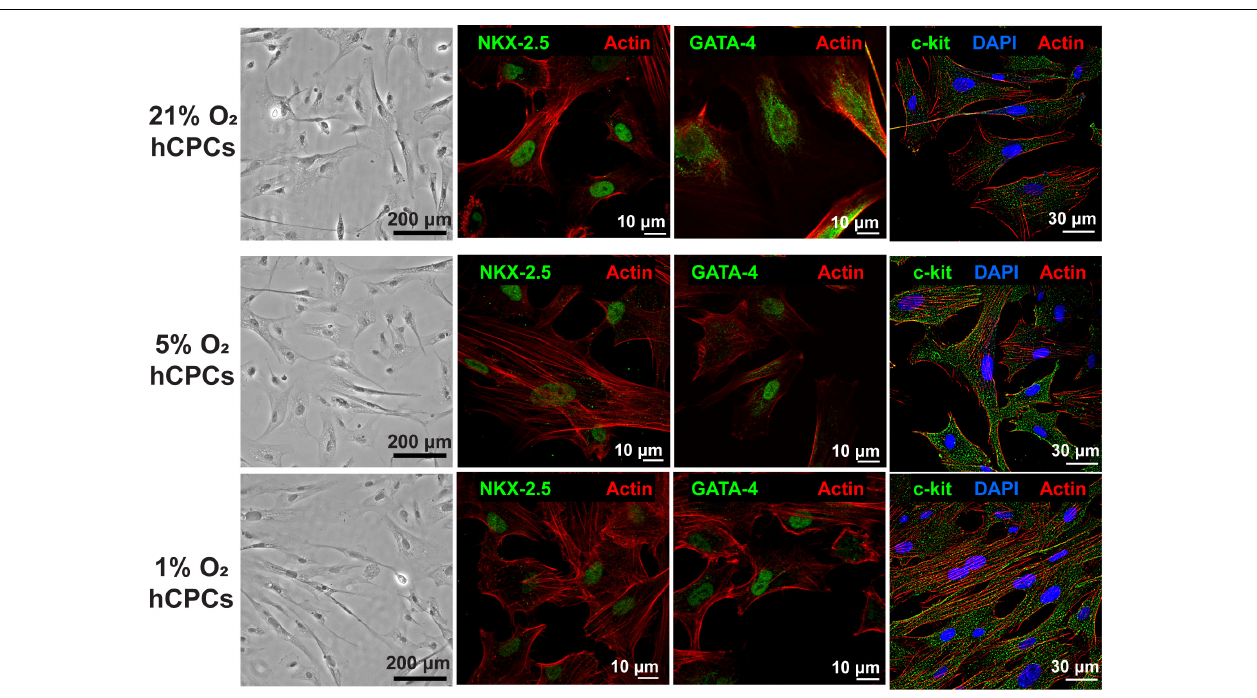
FIGURE 1 | hCPCs morphology and cardiac gene expression under normoxic and hypoxic microenvironments. Human CPCs were cultured under 21, 5, and 1% O 2 for 48 h. DIC imaging shows the typical morphology of cells, which is unchanged under hypoxia. Immunofluorescent staining for cardiac lineage markers NKX-2.5 (green, nuclear), GATA-4 (green, nuclear), and c-kit (green) showed their expression was maintained under all oxygen conditions. Nuclei are stained blue and F-actin is stained